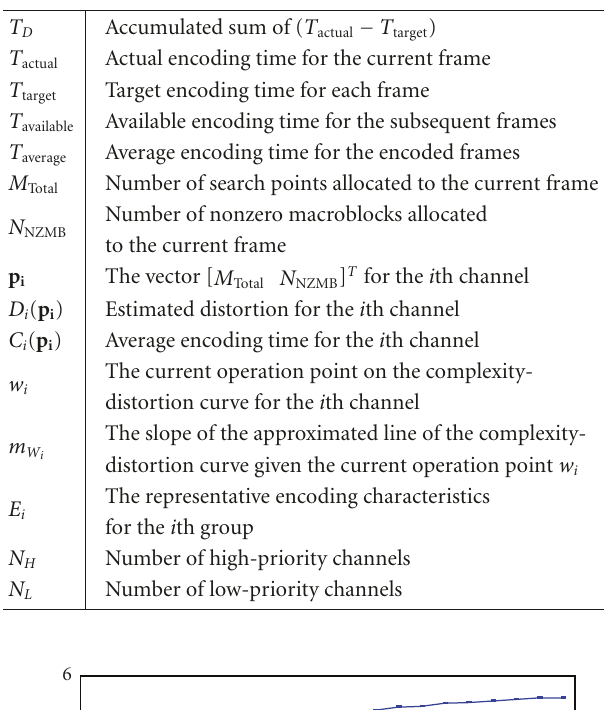
Table 1: Nomenclature.